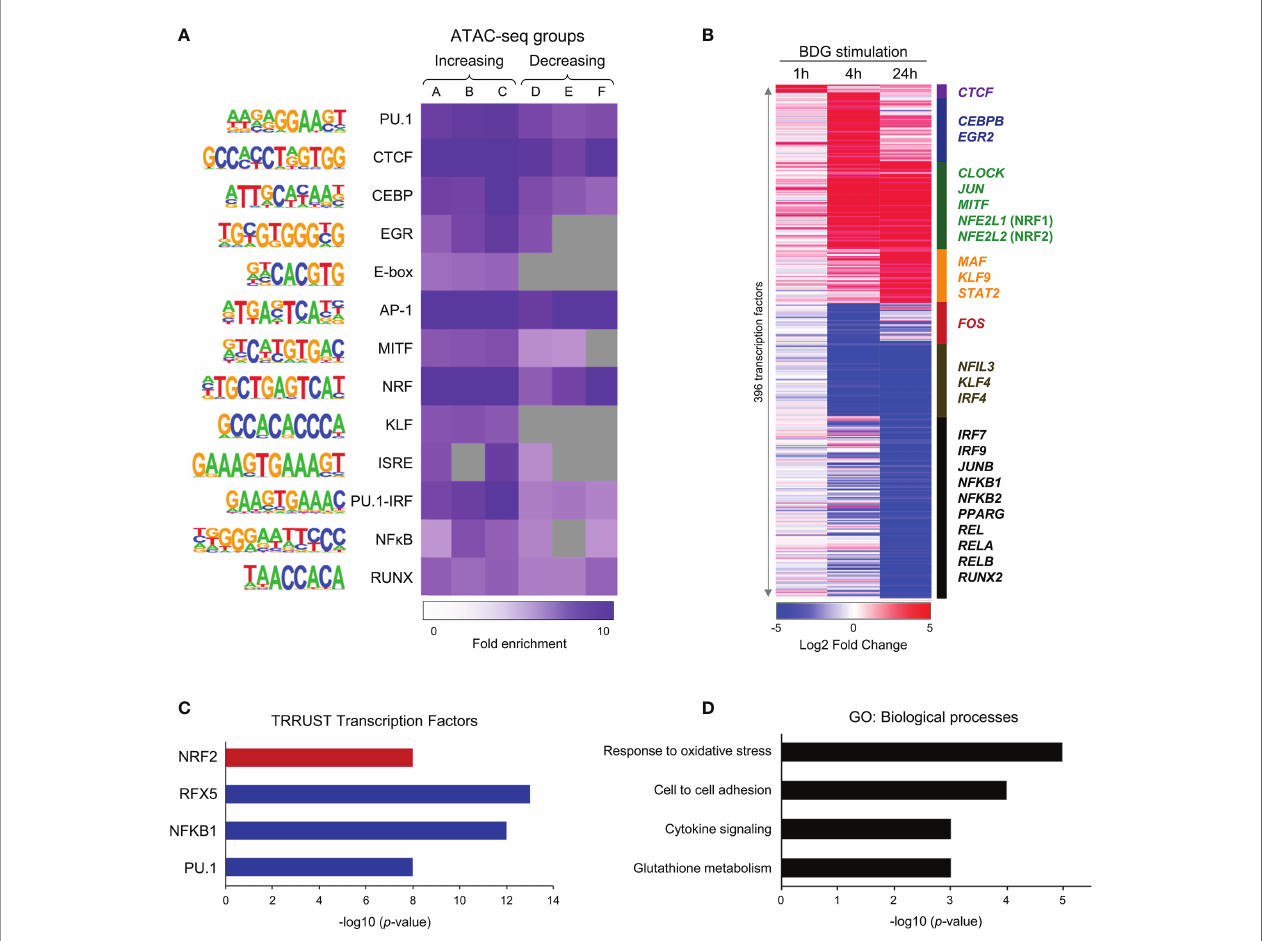
FIGURE 3 | Changes in motif enrichment and transcription factor expression in monocytes after BDG exposure. (A) Enriched motifs using Homer de novo motif analysis on the DAR clusters identi fi ed in Figure 1A . Color gradient indicates ratio of motif enrichment amongst regions in that cluster compared to randomly selected regions across the human genome with similar GC-content. Grey boxes indicate fold enrichment less than 1. (B) Heatmap of 342 differentially expressed transcription factors (TFs) after BDG exposure in the groups de fi ned in Figure 2C . (C) TRRUST query of genes signi fi cantly dysregulated by 24h BDG exposure vs random sets of genes against a database of all known cistromes. Red represents cistromes enriched in genes signi fi cantly upregulated by BDG exposure, blue represents cistromes enriched amongst genes signi fi cantly downregulated by BDG exposure (p < 10 -7 ). (D) Biological process gene ontology enrichment analysis of genes signi fi cantly upregulated by BDG exposure and enriched in the NRF2 cistrome (p <